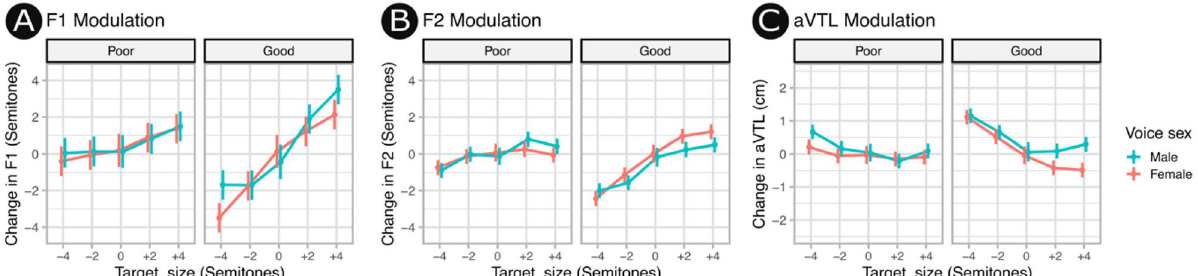
Figure 5. Modulation of ( A ) F1, ( B ) F2, ( C ) aVTL for good and poor vocal modulators as identified from rtMRI. Good vocal modulators of both sexes made greater changes to the acoustics of their voice than poor vocal modulators, particularly for F1. See additional analyses reported in Supplementary Materials 2.